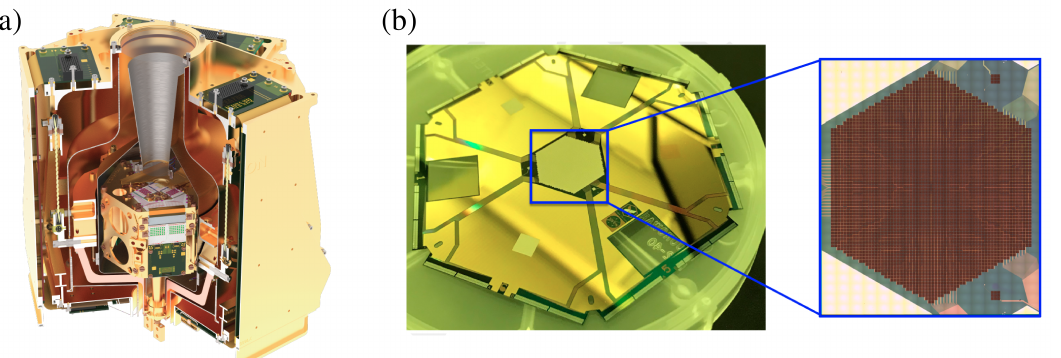
Figure 13. ( a ) X-IFU Focal Plane Assembly Demonstration Model. ( b ) Photograph of a X-IFU prototype array from NASA-GSFC with more than 3000 pixels on a pitch of 260 µ m. Courtesy of the X-IFU FPA team at SRON and